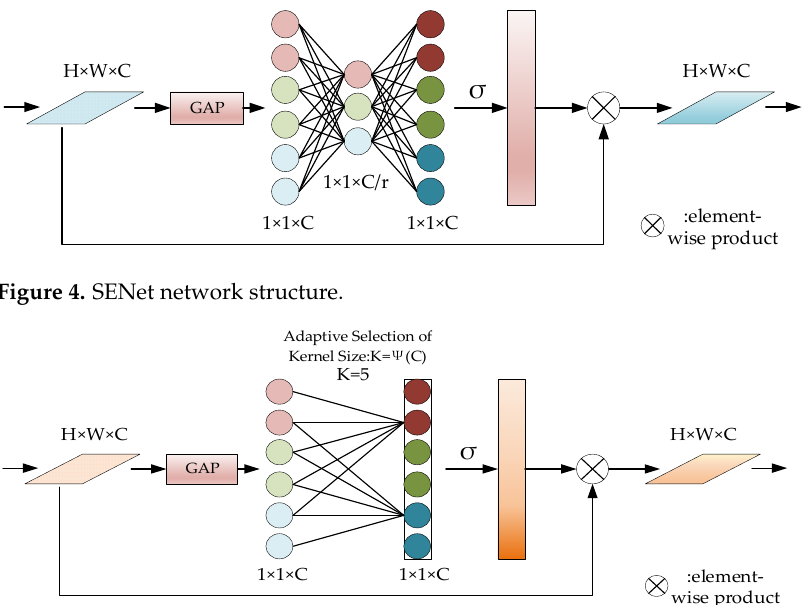
Figure 5. ECANet network structure.